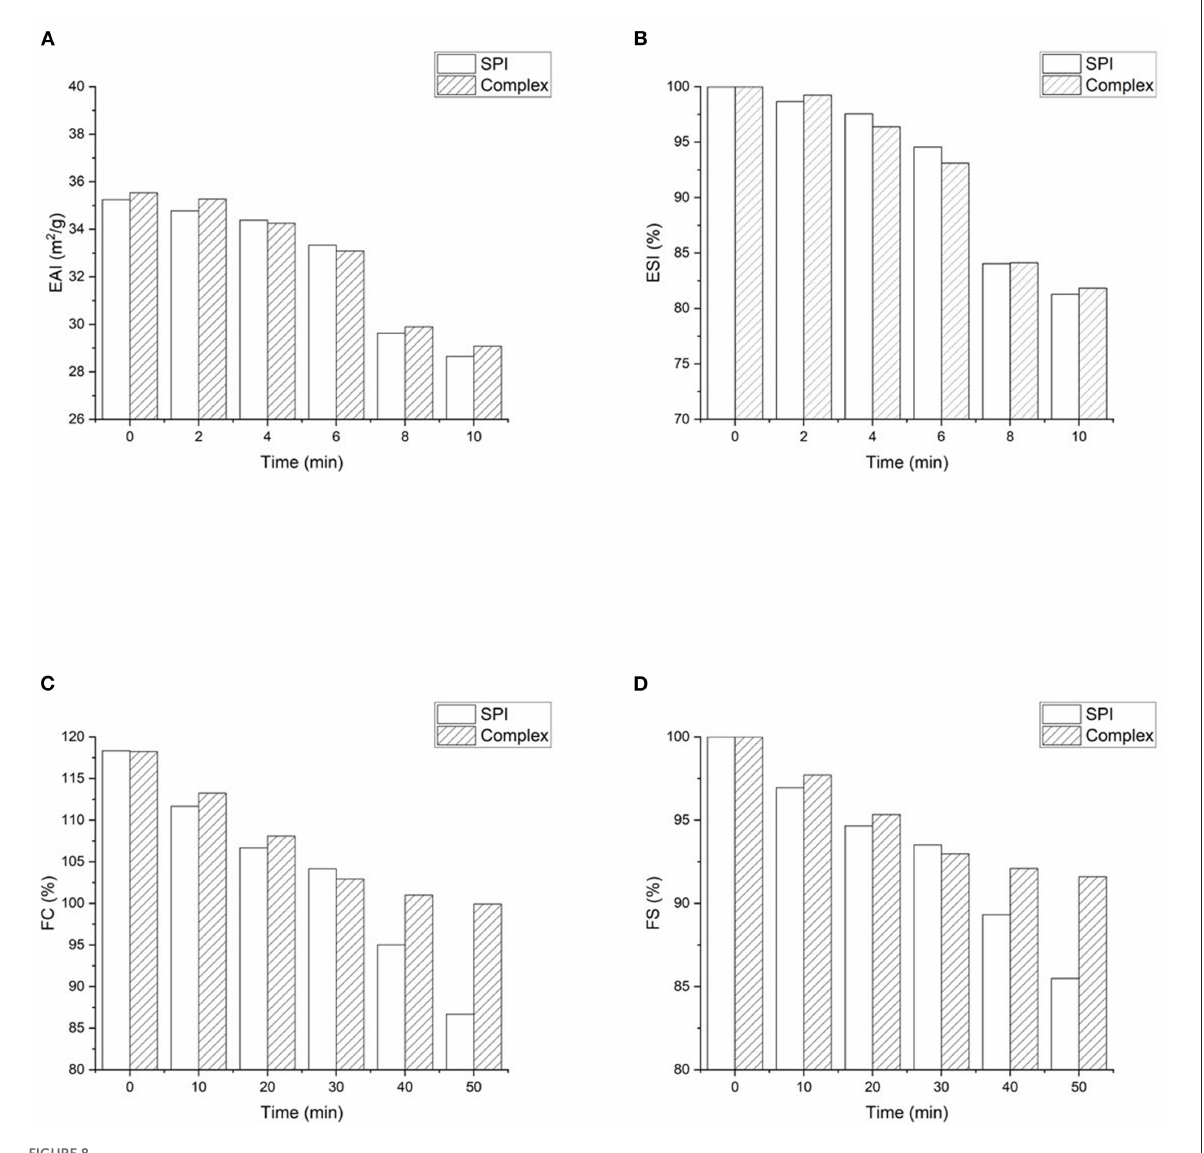
FIGURE8 Functional properties of SPI-quercetin complex: (A) Foaming capacity (FC); (B) foaming stability (FS); (C) Emulsifying activity index (EAI); (D) emulsifying stability index